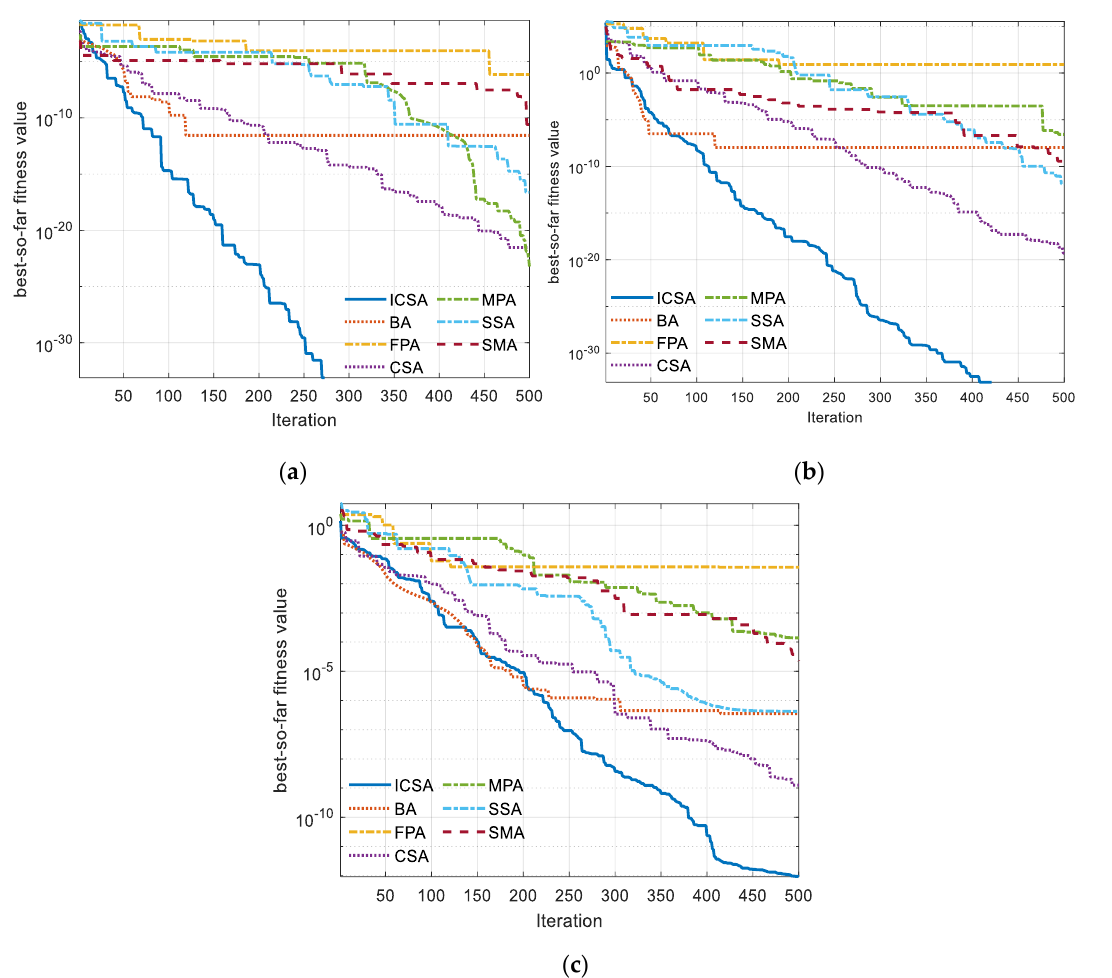
Figure 24. Convergence curve of the algorihms for various test cases: ( a ) Convergence curve for F32; ( b ) Convergence curve for F33; ( c ) Convergence curve for F34.